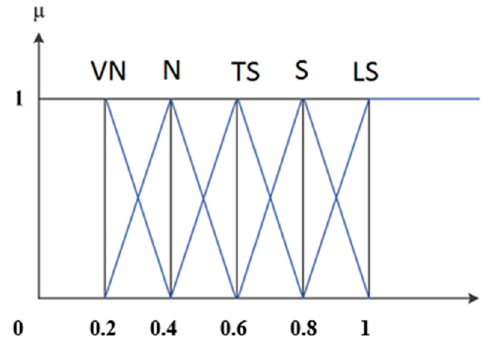
Figure 8. Fuzzy variable values for interfaces.